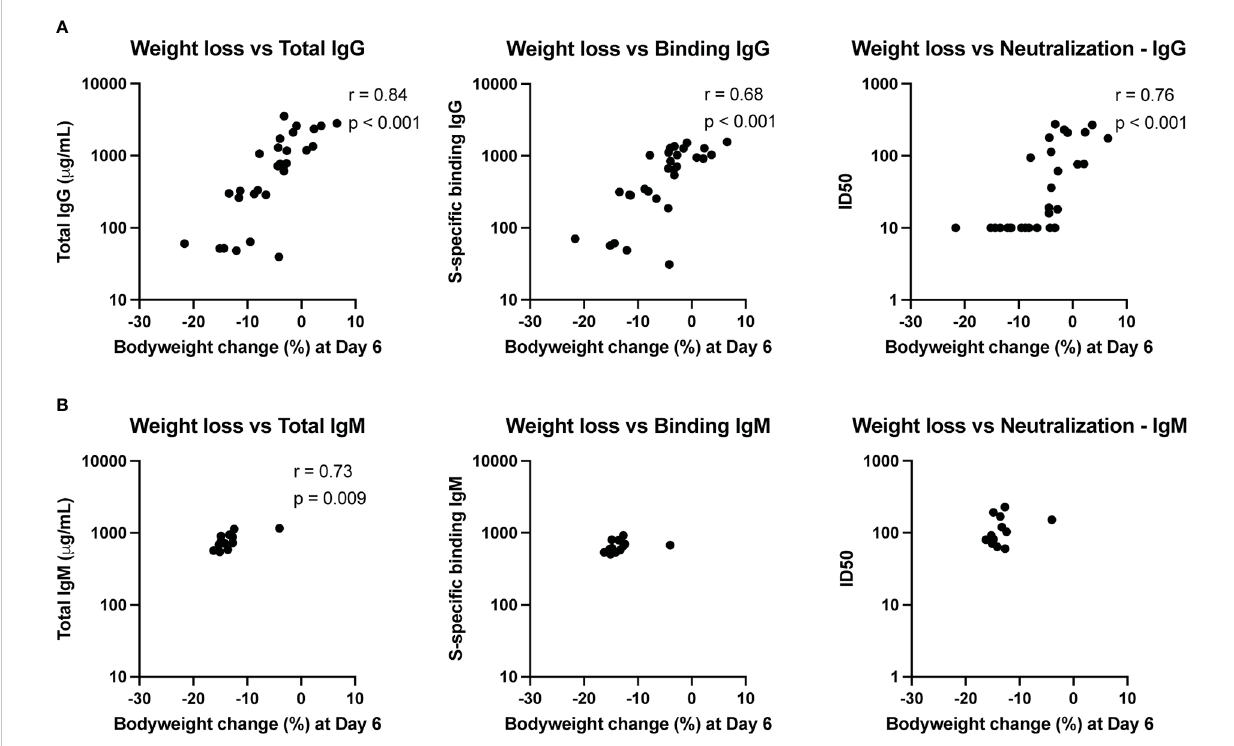
FIGURE 5 Immune correlates of protection. The relationship between total antibody levels, S-speci fi c binding antibody and neutralizing antibodies at the time of challenge and weight change at day 6 post-challenge was assessed by a nonparametric Spearman correlation for animals that received convalescent IgG (A) or IgM (B) . This analysis did not include animals that received naïve IgG or no antibody infusion. Binding IgG values represent the fold-change over a no-antibody